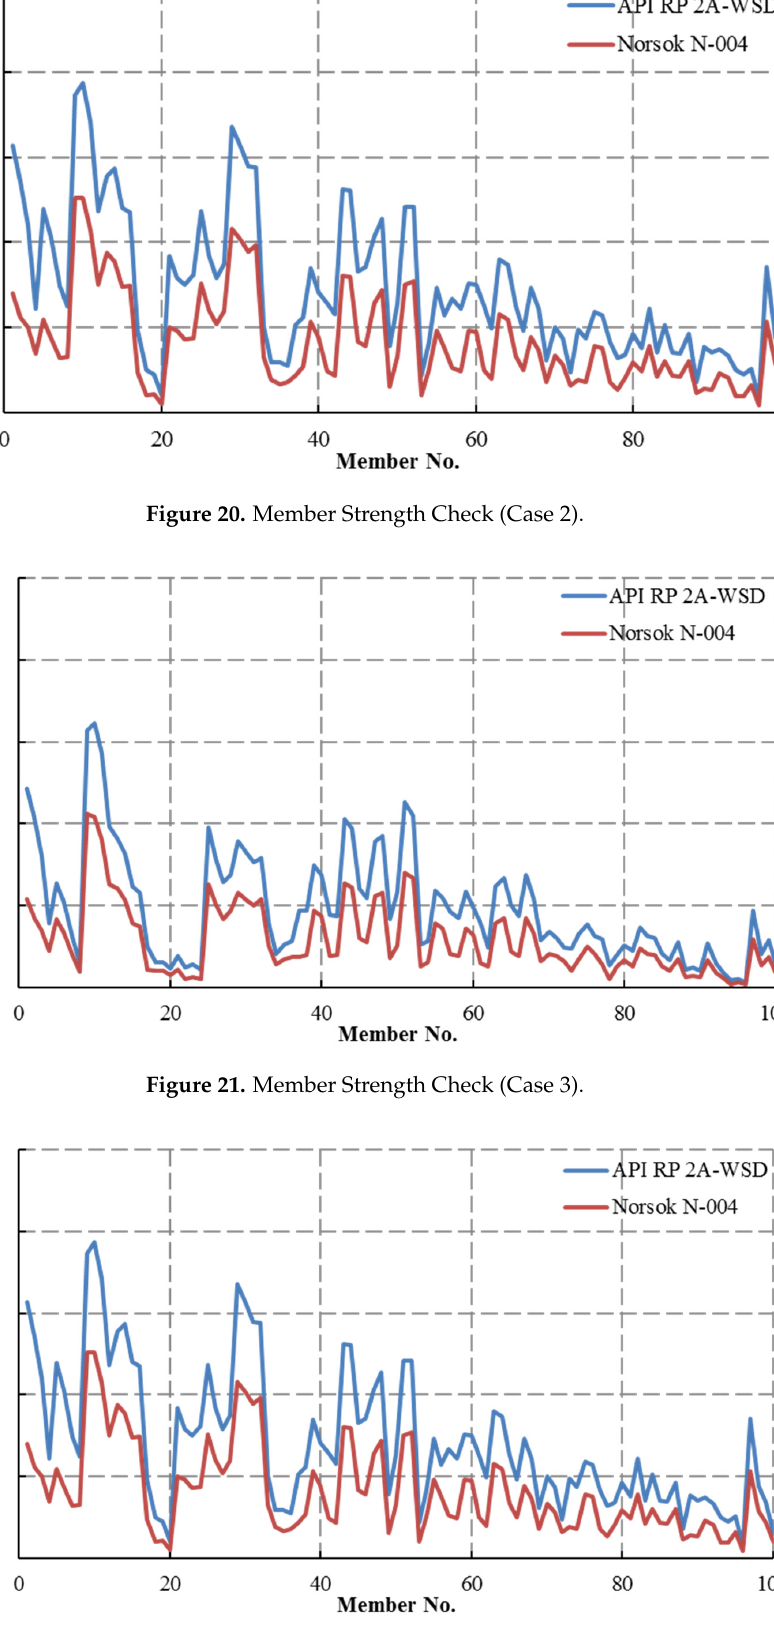
Figure 22. Member Strength Check (Case 4).